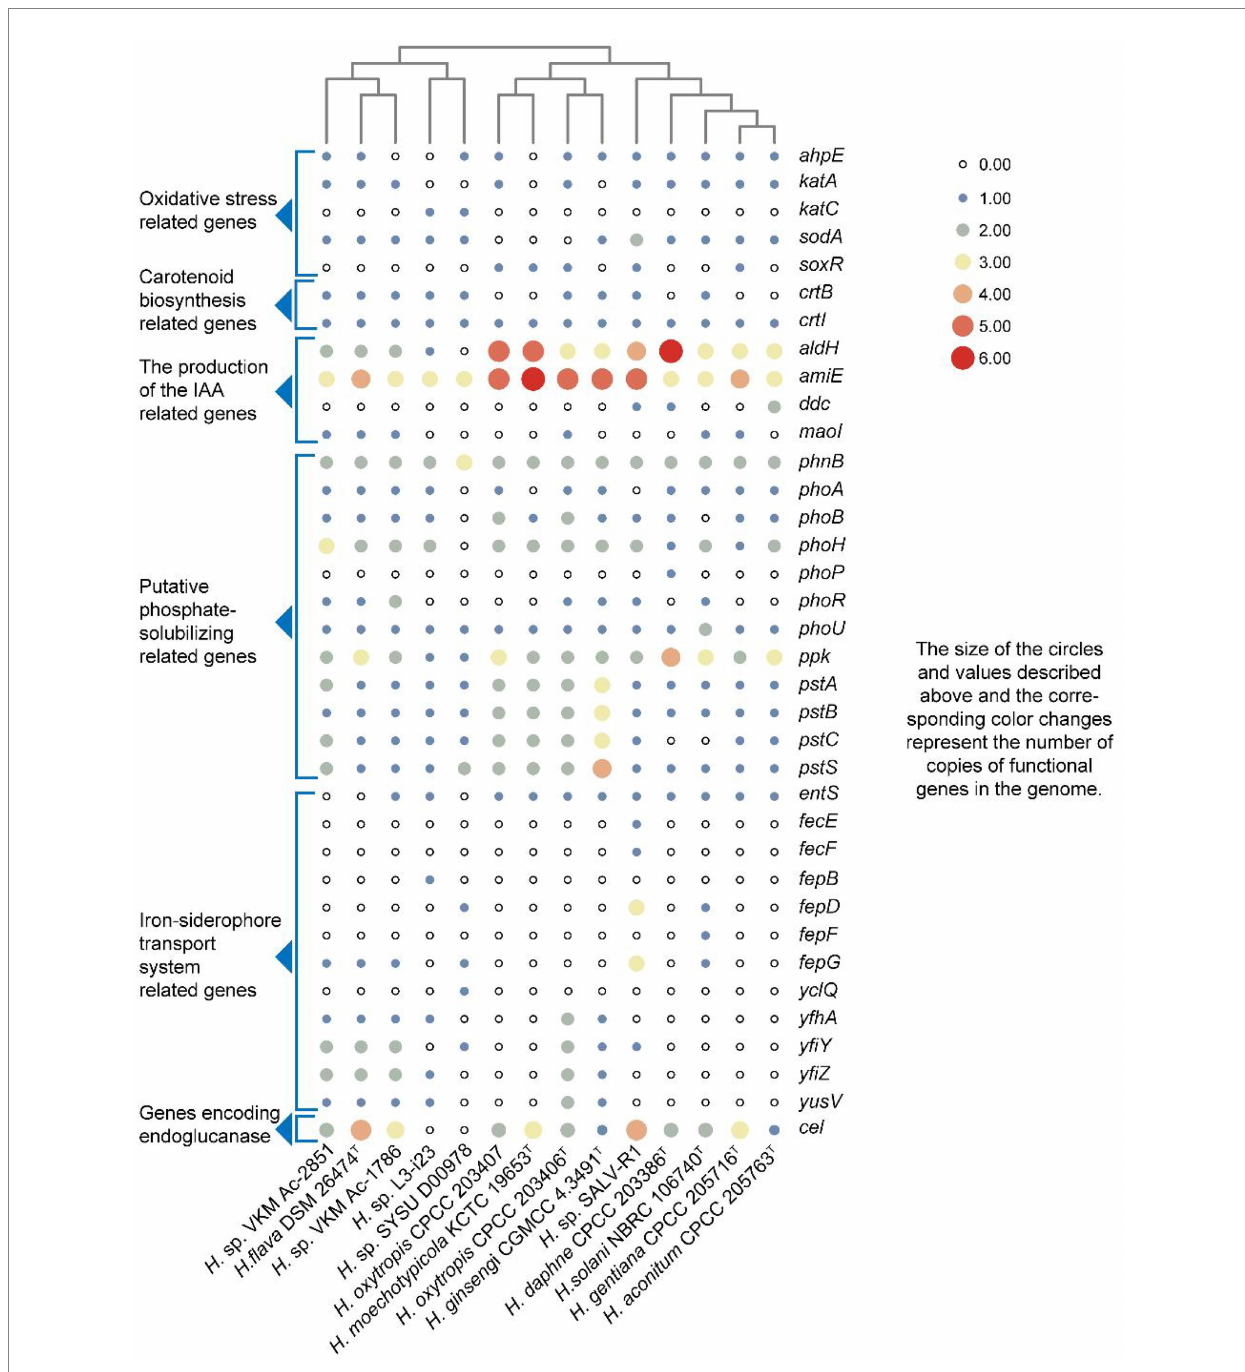
FIGURE 3 Heatmap of putative functional genes predicted from the 14 genomes of the genus Herbiconiux according to the copy number of the genes from the KEGG